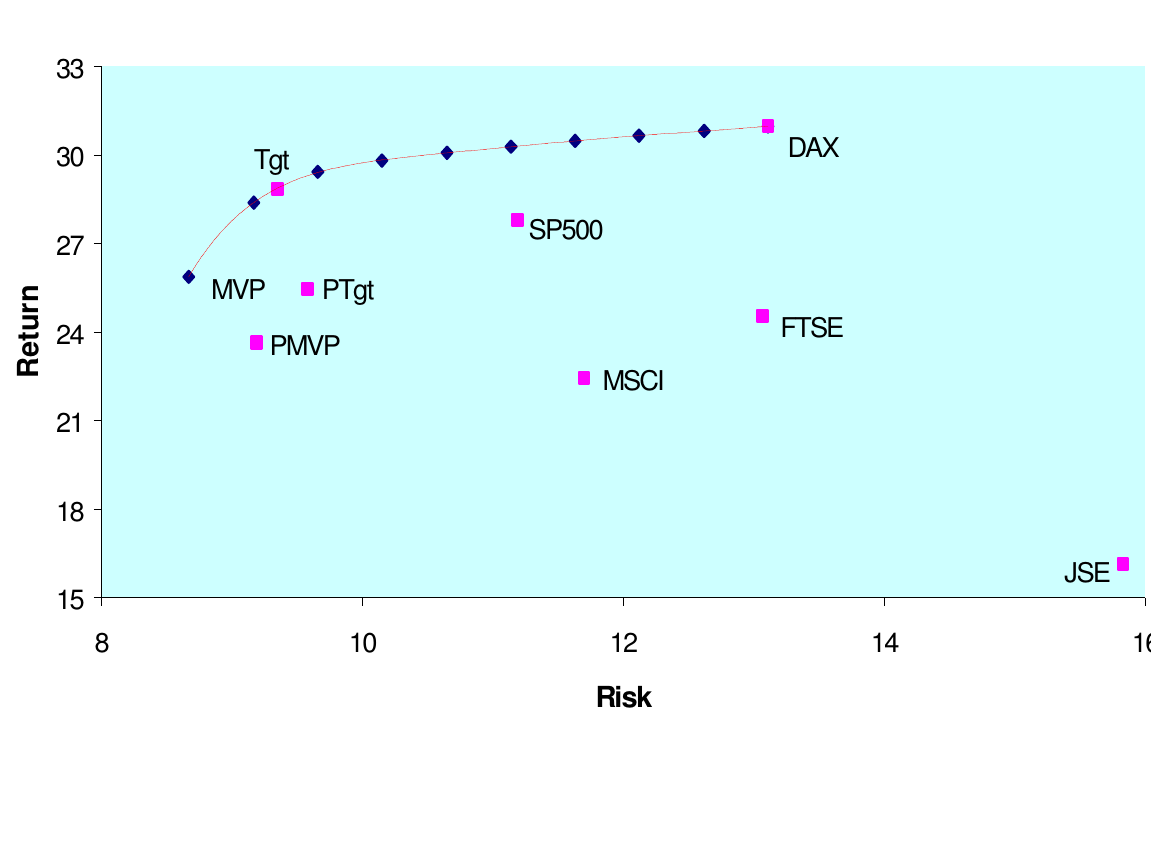
Figure 5: Efficient Frontier